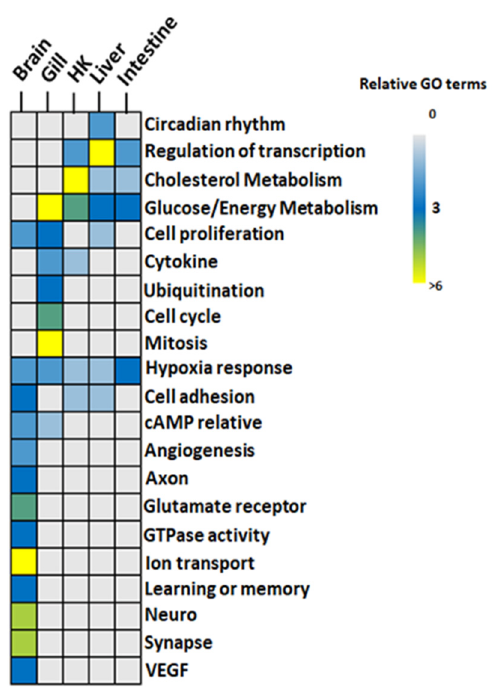
Figure 5. GO functions identified in hypoxia in five organs of common carp: GO terms from the GO similarity network were grouped. Color code: gray-to-blue (0–3 GO terms), blue-to-light green (3–6 GO terms), and yellow (>6 GO terms). HK: Head Kidney.